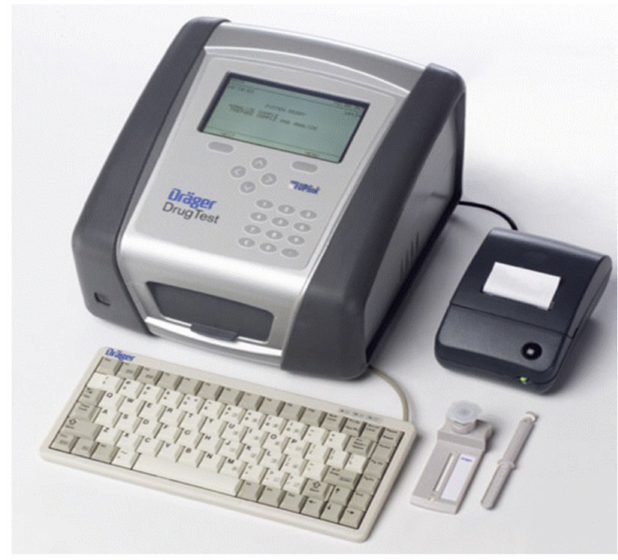
Figure 16. Uplink/Drug test device [50].